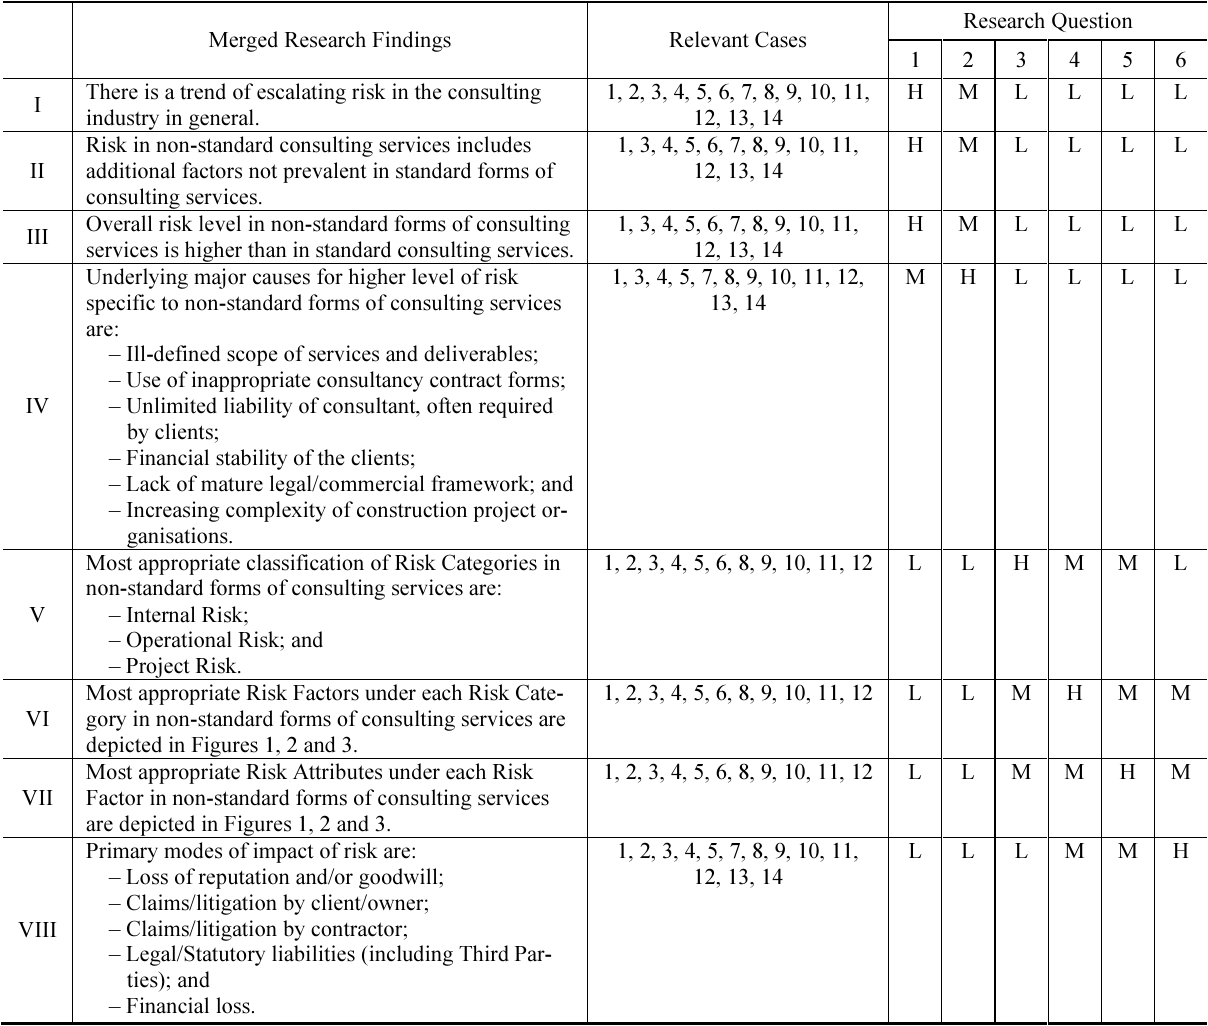
Table 5. Matrix for generating research findings Merged Research